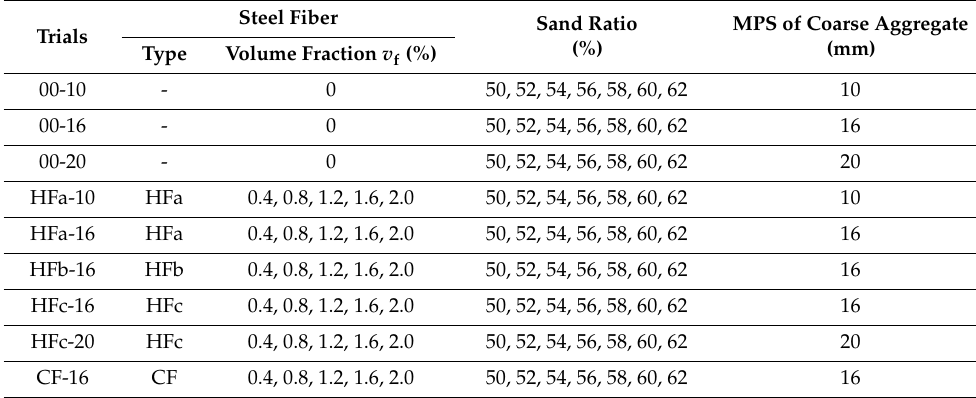
Table 4. Experimental